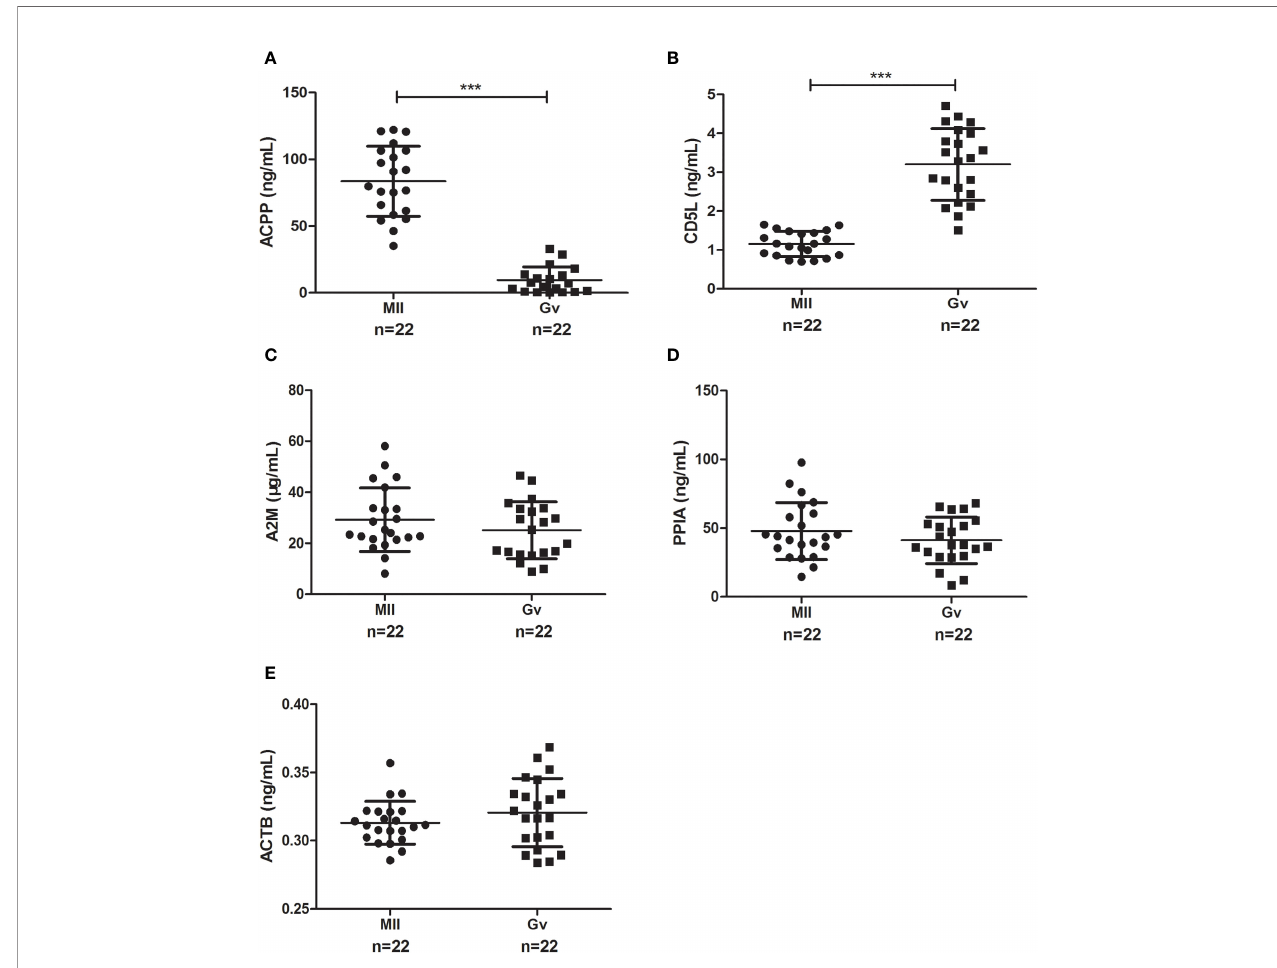
FIGURE 4 | Enzyme-linked immunosorbent assay results of candidate proteins in MII and Gv oocytes in follicular fl uid. (A) Prostatic acid phosphatase (ACPP); (B) CD5 antigen-like (CD5L); (C) Alpha 2 macroglobulin (A2M); (D) Peptidyl-prolyl cis-trans isomerase A (PPIA); (E) Beta-actin (ACTB). *** P <